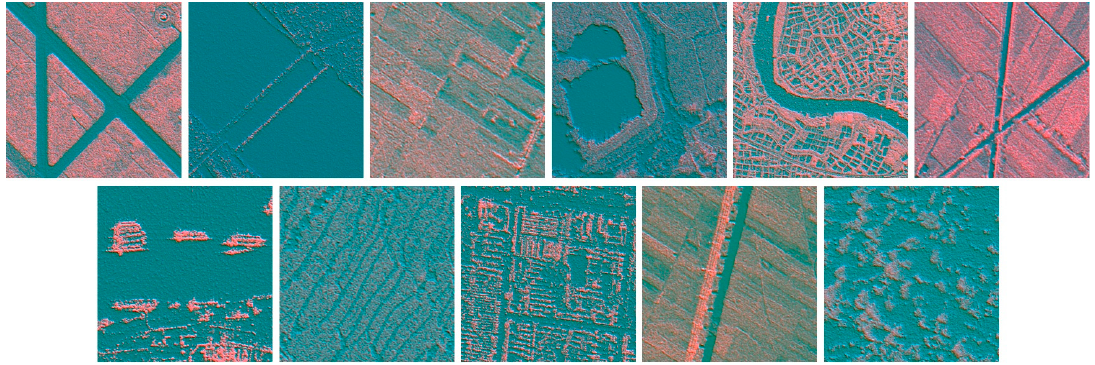
Figure 8. The fusion map of two feature maps of MSOGDF for the 11 types of scenes .